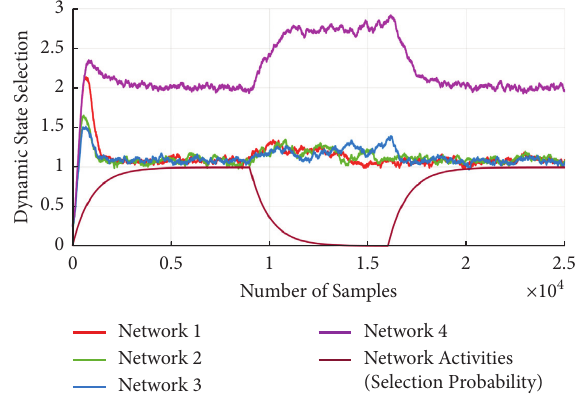
Figure 1: Effect of threshold on network connectivity for � 0 ) . sensitivity � 5 ( V thrl